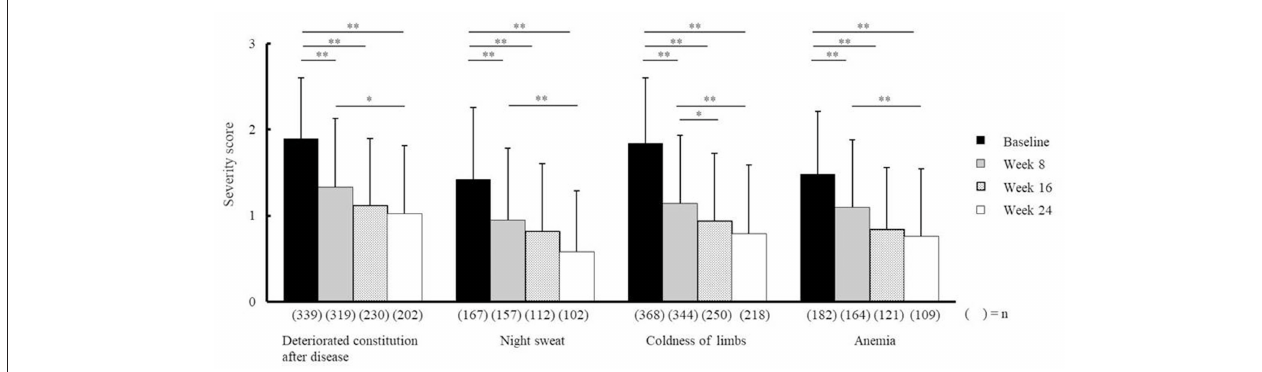
FIGURE 3 | Effectiveness of Ninjin’yoeito according to physician assessment. Changes in severity scores for deteriorated constitution after disease, night sweat, coldness of limbs, and anemia after Ninjin’yoeito (NYT) administration, Data are presented as the mean ± standard deviation, * p < 0.05 and ** p < 0.01 compared with the baseline as determined using the Bonferroni Method. ( n ), number of patients.